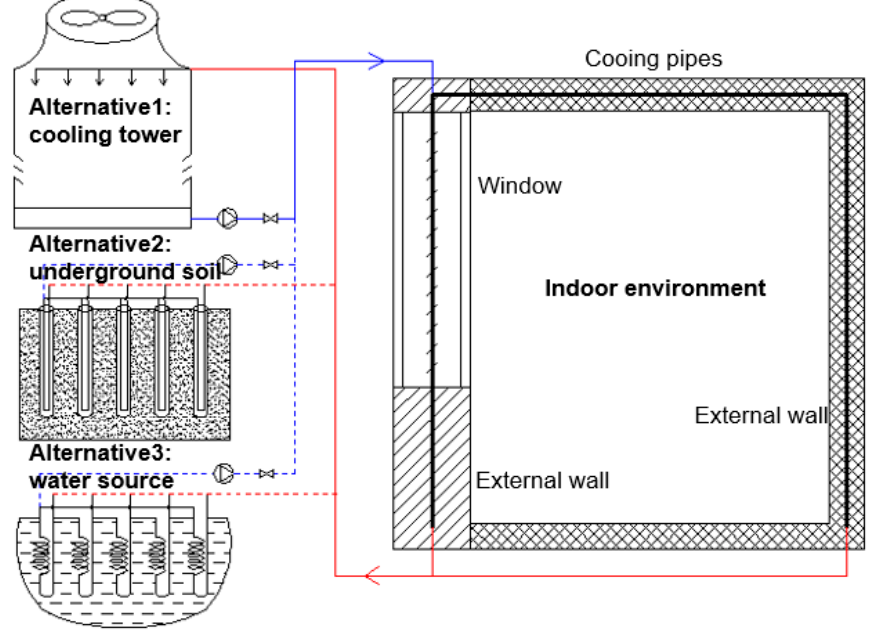
Figure 1. Sketch of the pipe-embedded envelope connected with natural sources.